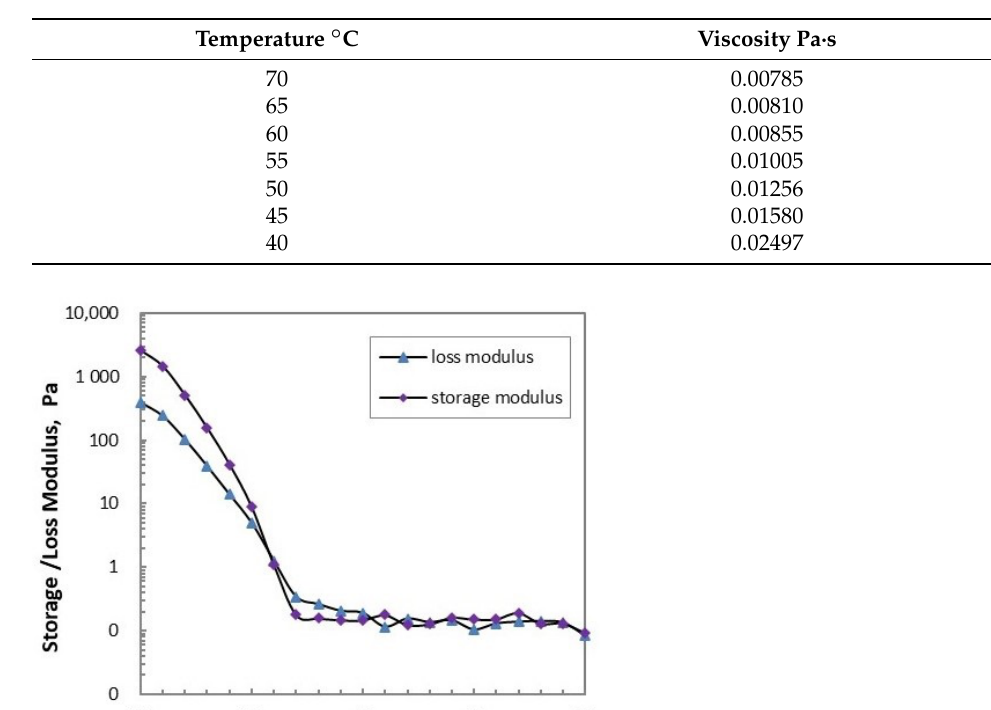
Table 1. Newtonian viscosity at different temperatures, tested under different shear rates 20 s − 1 , 50 s − 1 , 100 s − 1 . Data provided by Zhang [12].